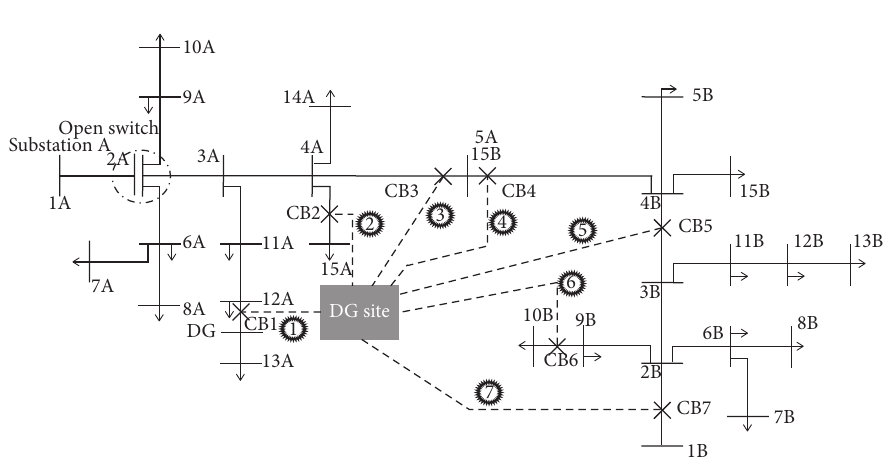
Figure 3: Single line diagram of topology no.